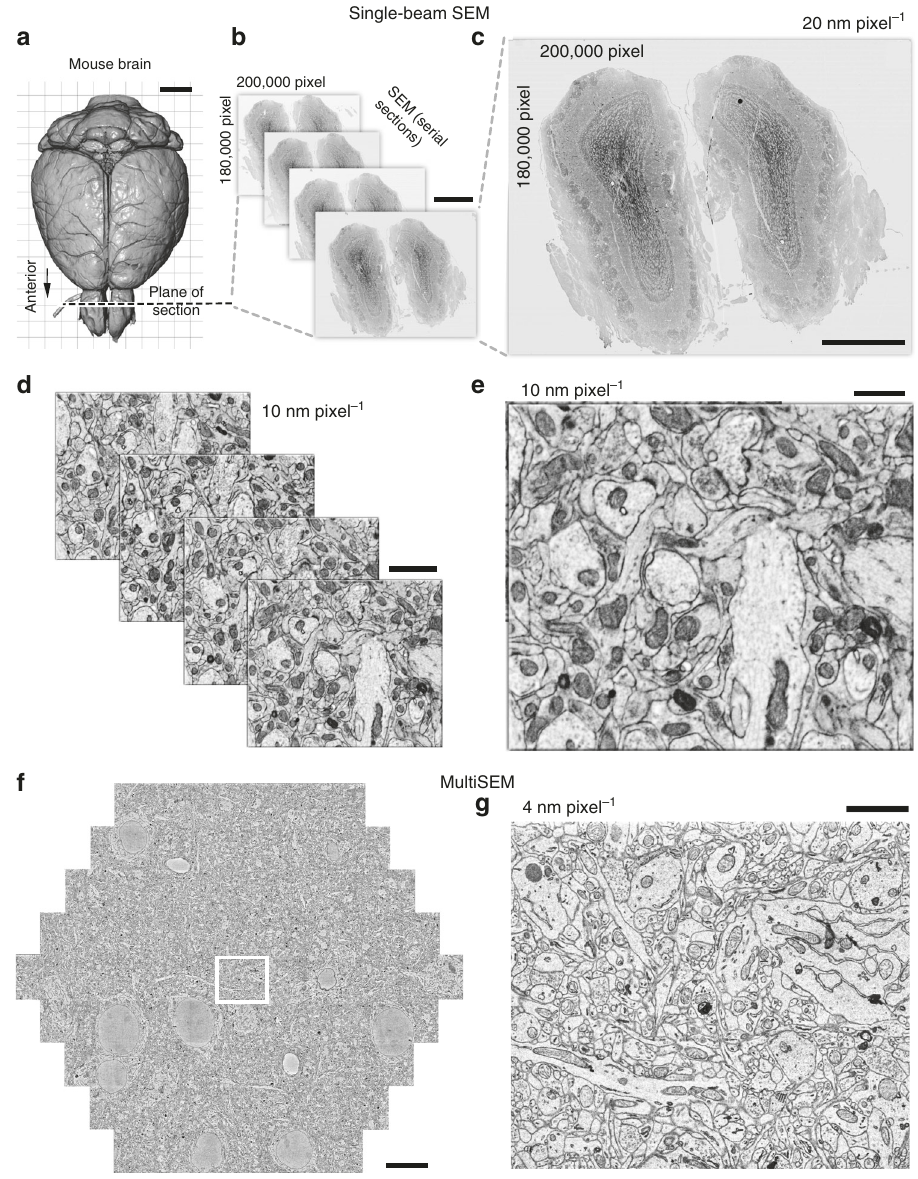
Fig. 7 CNT tape provides good imaging conditions for large brain sections with single beam SEM ( a - e ) and MultiSEM ( f , g ). a 3D reconstruction of an adult mouse brain based on X-ray microCT. Scale, 2 mm. b Olfactory bulb serial sections (100 nm-thick) collected onto CNT tape are largely wrinkle-free and can be imaged with a BSE detector in high vacuum without charging. Scale, 1 mm. c Enlargement of an SEM mosaic, consisting of 3078 individual image tiles, with areas of the olfactory bulb indicated. Scale, 1 mm. d High-magni fi cation stacks through the serial sections shows intact cellular membranes and well-stained synapses suitable for neuronal circuit reconstructions. Scale, 2 µ m. e Enlarged serial section from d . Scale, 1 µ m. f MultiSEM image of mouse primary somatosensory cortex captured with 4 nm pixel − 1 , 3128 × 2724 pixels image size for each beam, 100 ns dwell time and 1.5 keV landing energy. Stitched hexagon of ~35 nm thick section of cortical mouse brain tissue. Scale, 10 µ m. g Enlarged single tile image outlined by the white rectangle in f . Scale, 2 µ